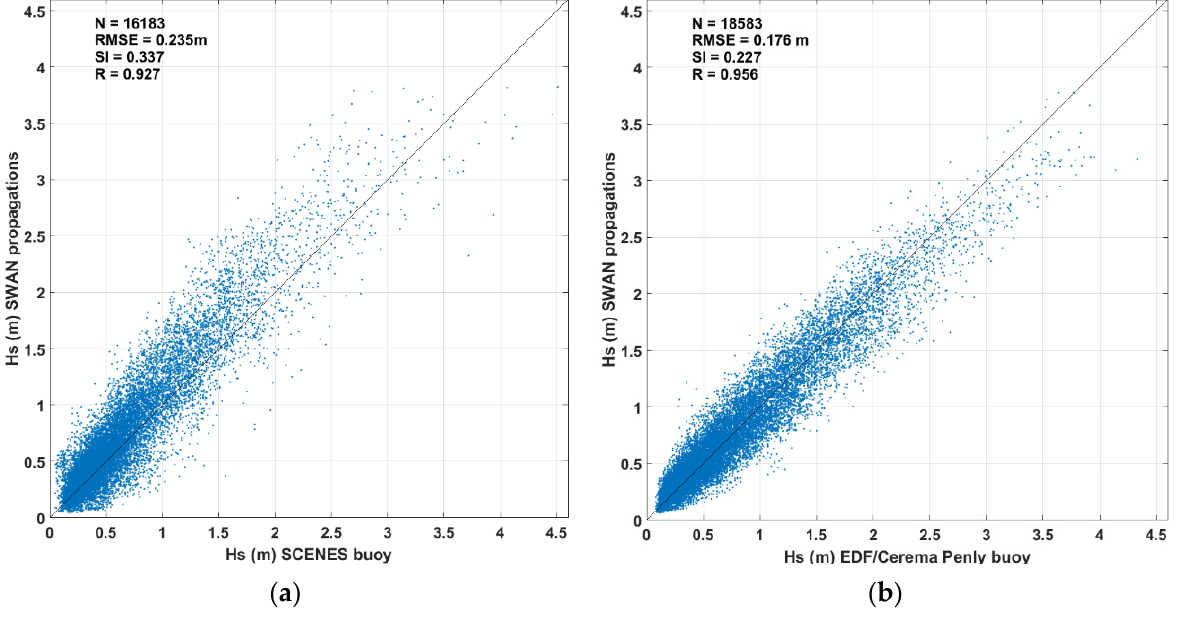
Figure 4. Significant wave height ( H s ) comparison of results of simulations from the SWAN model versus observations measured by ( a ) SCENES buoy for Etretat and ( b ) campaign 07608 for Hautot- sur-Mer.